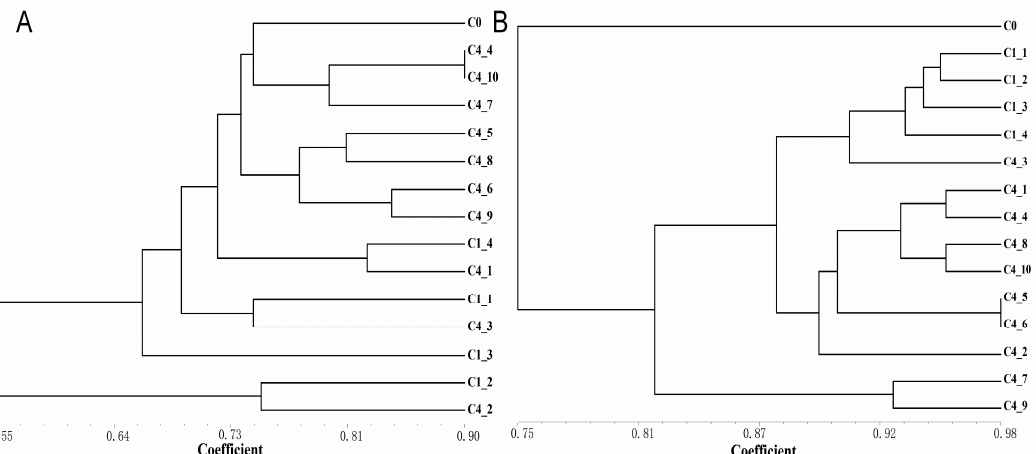
Figure 8. The UPGMA dendrogram of somatic clones derived from R. bailiense calli as revealed by IRAP ( A ) and ISSR ( B ) markers. To assess the robustness of each node, a bootstrap with 1000 replicates was performed on the data on loci.